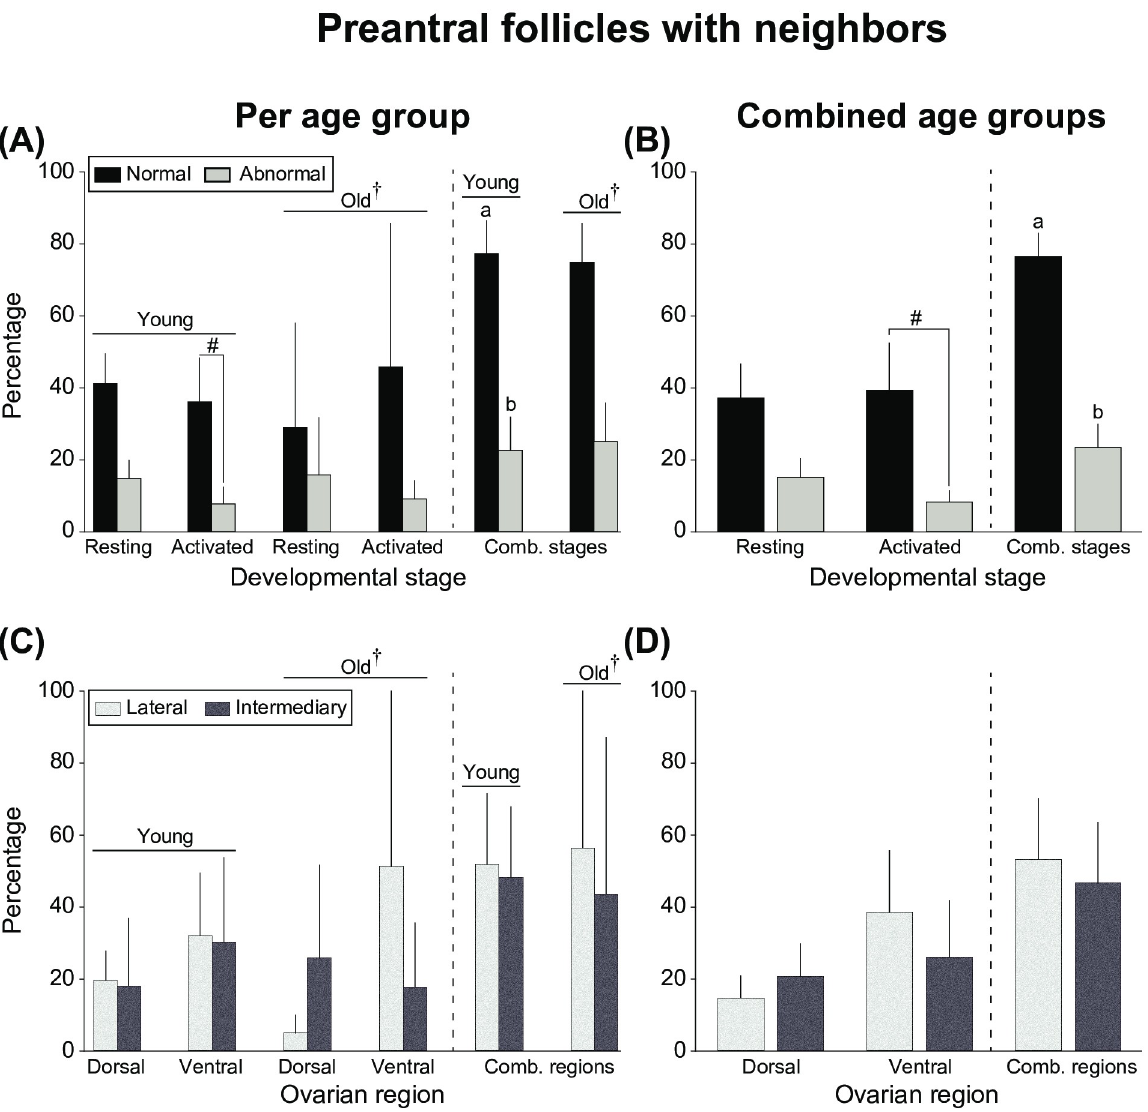
Fig 4. Mean percentages ( ± SEM) of preantral follicles with neighbors considering (A, B) morphology and developmental stage and (C, D) ovarian portions and regions (A, C) per age group and (B, D) with age groups combined. a,b Within combined stages, values without a common superscript differed. # Indicates tendency ( P = 0.07–0.08) between morphologies within the activated developmental stage. † Statistical analyses could not be run on the old age group due to the low number (n � 2) of old mares that had follicles with neighbors. No differences ( P > 0.05) were observed for any of the end points considering resting follicles or ovarian portions and regions. All data were analyzed using one-way ANOVA after arc sin square root transformation. Comb.,